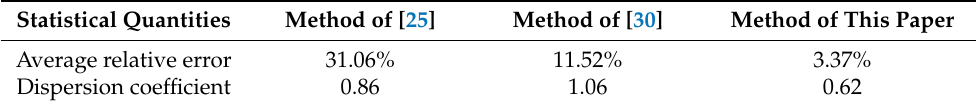
Figure 9. Relative errors of the third shear calculated by the method of this paper, the method of Yan, W 2003 [25] and the method of Pan, L 2004 [30]. Table 4. Average relative errors and dispersion coefficient of the third shear.